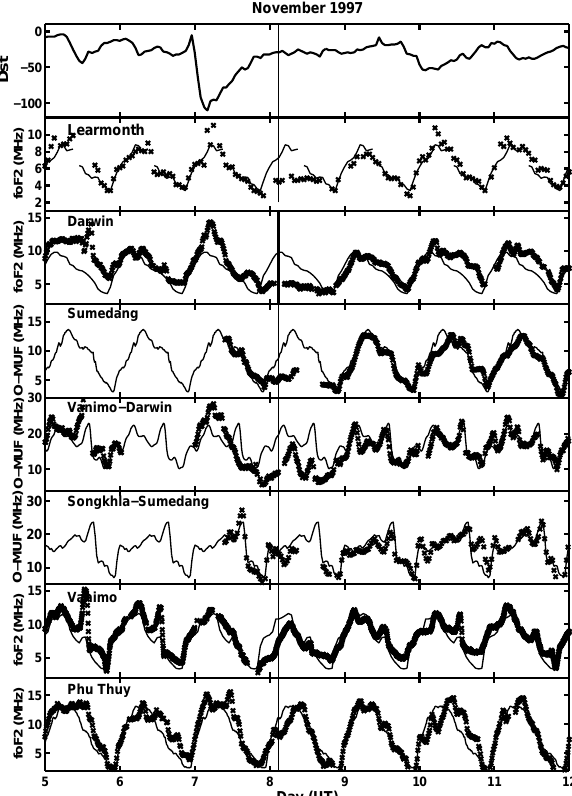
Fig. 6. TOPEX/Poseidon passes and corresponding TEC values ob- served between 16:10–14:09 LT) over the period 21–31 October 1997. The negative ionospheric storm day TOPEX pass on 25 Oc- tober is shown in black and on the preceding day, 24 October, in green.